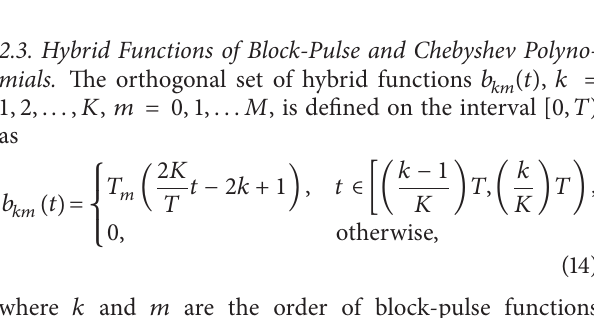
Table 2: The maximum errors of 𝐸 𝐾𝑀 for different values of 𝐾 and 𝑀 . 𝐾 4 10 8 𝑀 8 𝐸 6.66 × 10 𝐾𝑀